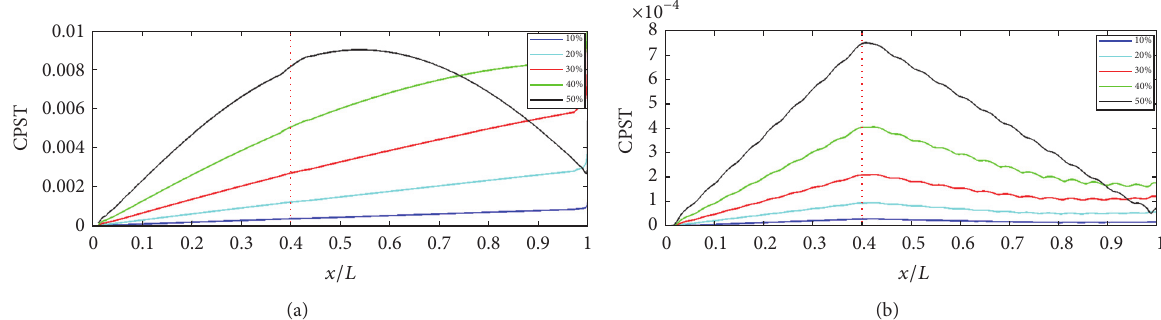
Figure 18: CPST of different damage levels with the mass which is 400Kg: (a) is for the acceleration responses and (b) is for the displacement responses.